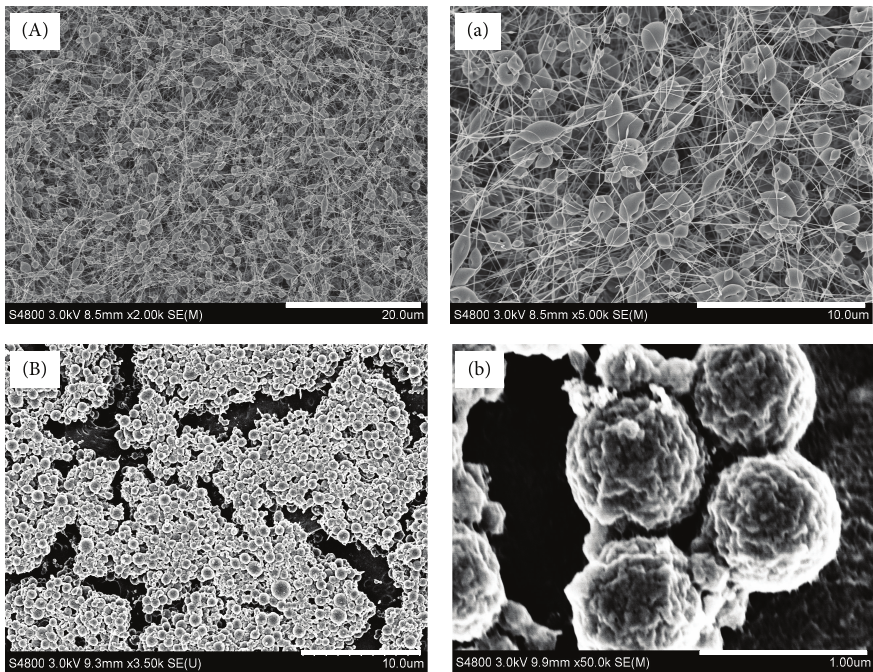
Figure 2: (A, a) SEM images of electrospun ASF/PEO bead-on-string structures and (B, b) SEM images of ASF particles. Scale bars: (A) 20 𝜇 m, (a, B) 10 𝜇 m, and (b) 1 𝜇 m.